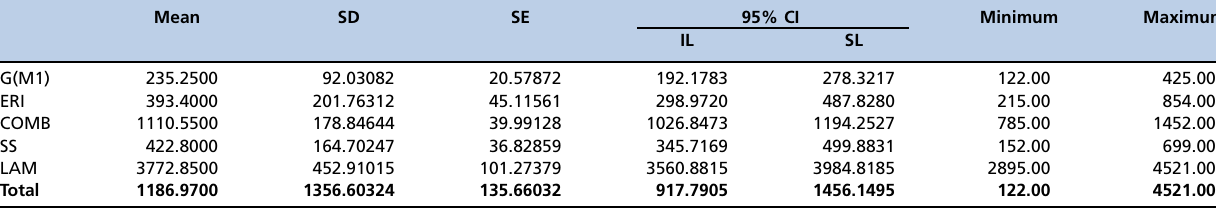
Table 2 - Motor evoked potential results: amplitude in the lower limbs in each group. Mean SD SE 95% CI